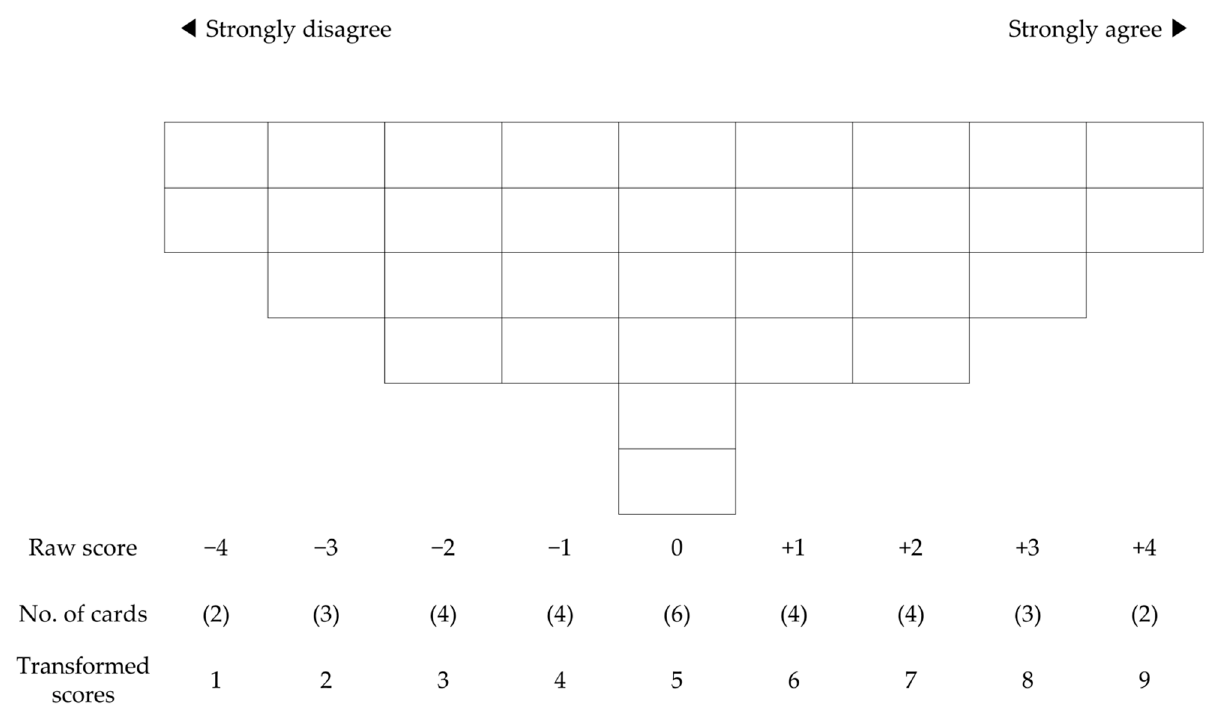
Figure 2. Score sheet used for ranking the statements.